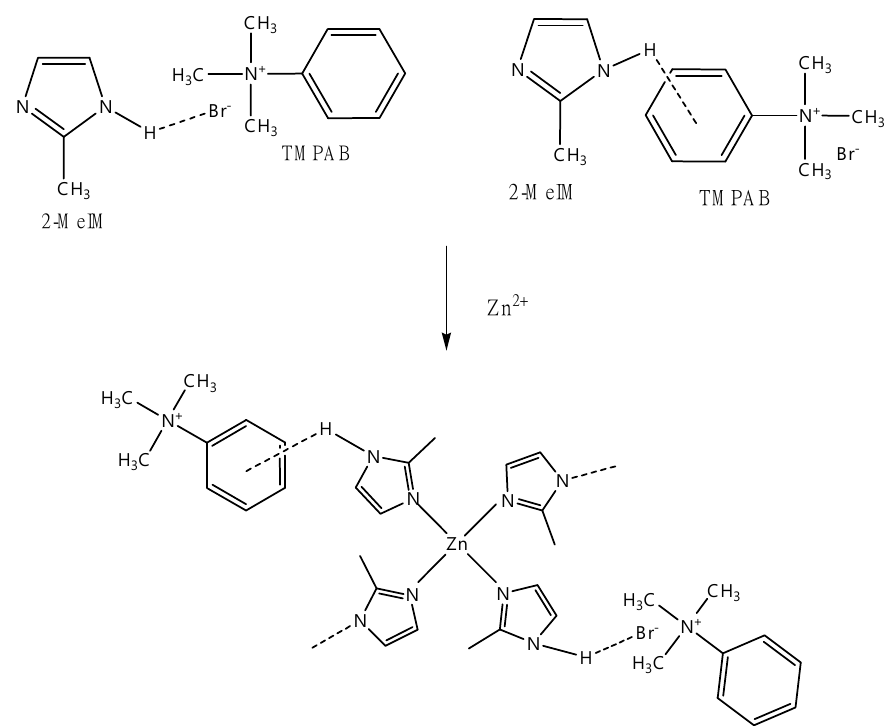
Figure 5. Proposed ZIF-8 formation mechanism with the use of trimethylphenyl ammonium bromide (TMPAB) as hydrogen bond acceptor.